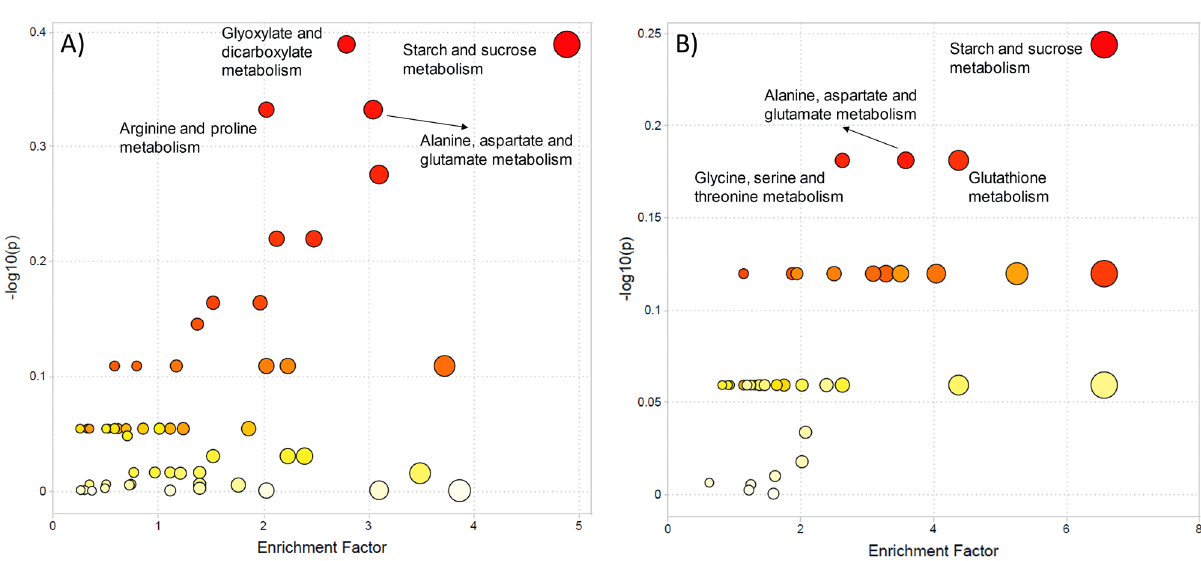
Figure 4. Metabolic pathway activity using the mummichog algorithm from ( A ) UHPLC–ESI(+)–MS and ( B ) UHPLC–ESI–(−)–MS